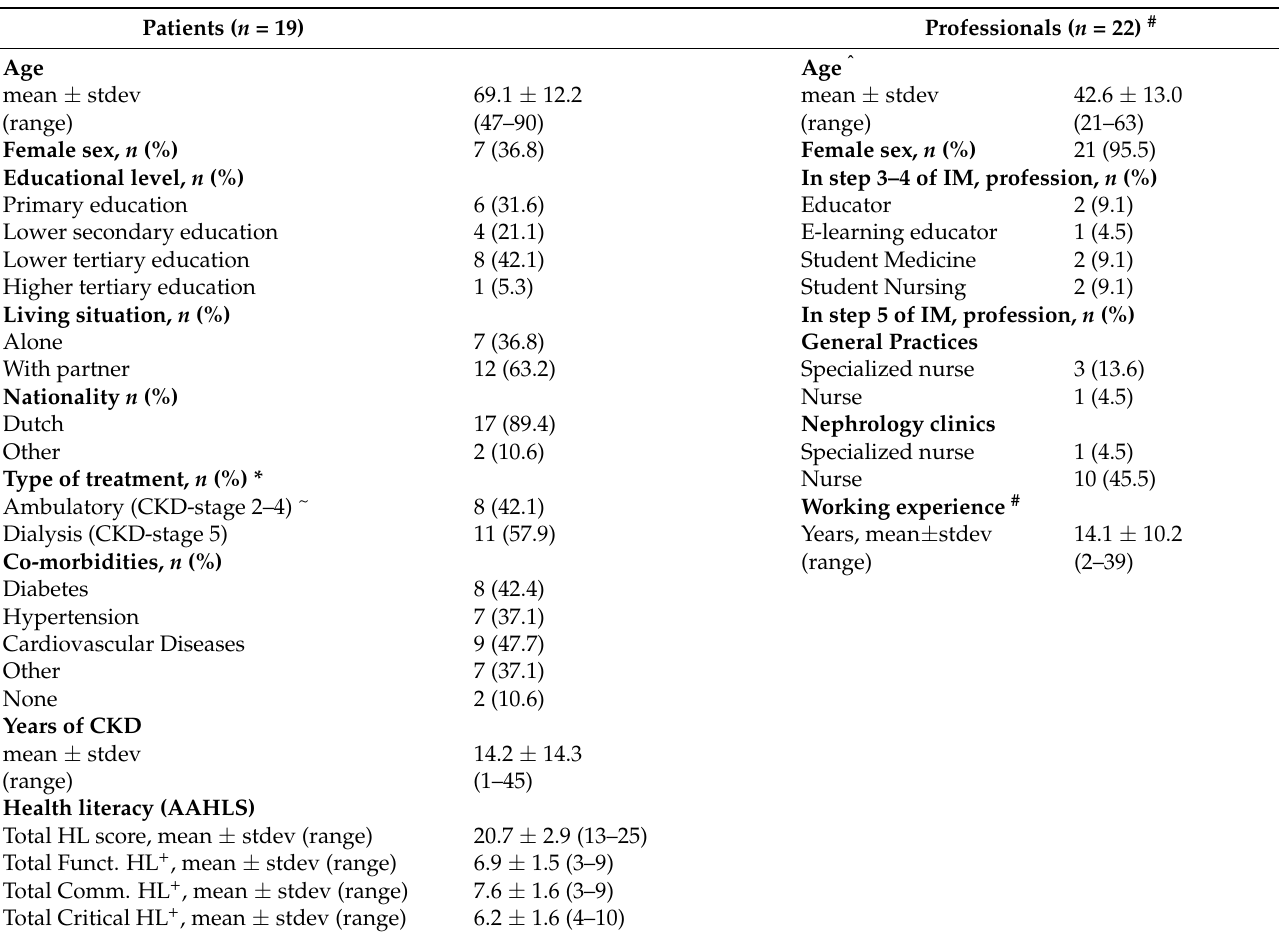
Table 1. Characteristics of patients, health care professionals, educators and